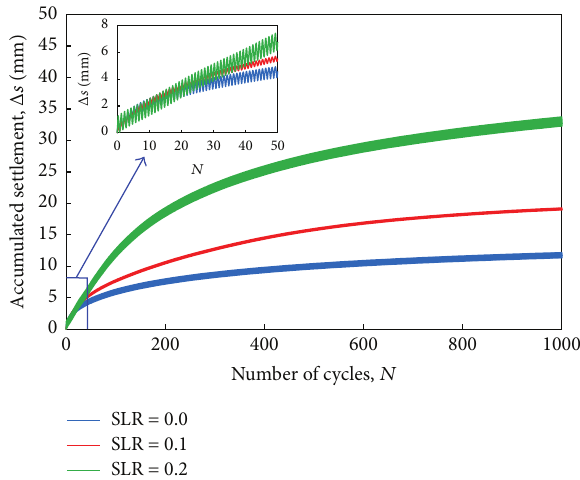
Figure 10: Development of accumulated displacement during dynamic loading tests (CLR = 0.60).